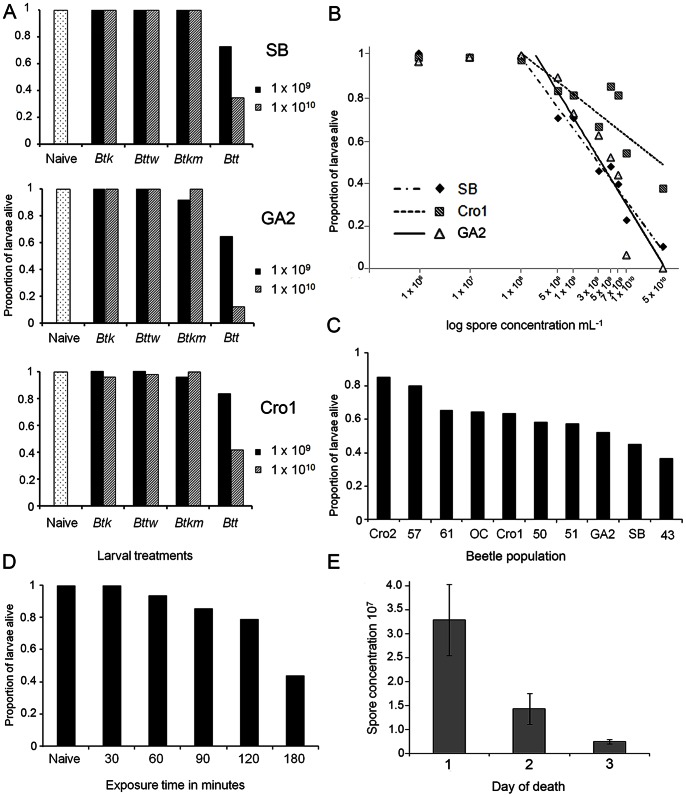
Infection of T.
castaneum with B. thuringiensis. (A) Insecticidal activity of different Bt strains to T. castaneum larvae.Larval survival at day seven after constant exposure to flour containing Bt spores with two different concentrations, 109 mL−1 and 1010 mL−1 of four different Bt strains. Insect populations infected: San Bernardino (SB), Georgia 2 (GA-2), Croatia 1 (Cro1). (B) Dose response curves for
Btt
 infection. Survival of three populations of T. castaneum larvae (SB, GA-2 and Cro1) at day seven after constant exposure to different concentrations of Btt spores in flour. We fitted linear regression curves to the log transformed values of spore concentrations, excluding the first two values where no mortality was induced (SB: survival = 3.68–0.15*log spore concentration, r2 = 0.97, p = <0.0001; Cro1: survival = 2.56–0.08*log spore concentration, r2 = 0.70, p<0.01; GA-2: survival = 4.35–0.18*log spore concentration, r2 = 0.89, p<0.001). (C) Differences in susceptibility to
Btt
 among ten beetle populations. Survival of ten populations of T. castaneum larvae at day seven after constant exposure to Btt spores in flour (5×109 mL−1). (D) Limited exposure time to
Btt
 spore-containing diet. Survival of T. castaneum larvae (SB population) 24 hours after limited exposure time to spore-containing diet. Survival is shown for 24 hours post initial exposure (PIE) since 48 hours PIE no additional mortality was observed. (E) Spore load of cadavers after infection with
Btt
. Total spore number recovered from larvae that were collected on first, second and the third day of death.